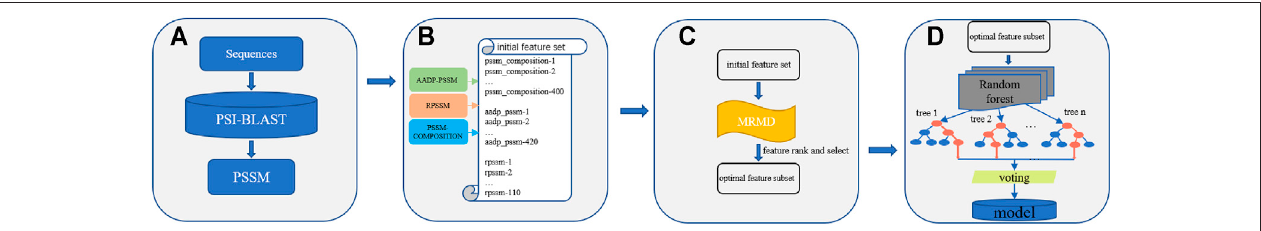
FIGURE1| FrameworkofKK-DBP. StepA :ConstructionofPositionSpeci fi cityScoreMatricesforproteinsequences. StepB: Extractionofthreefeatures:AADP- PSSM, PSSM-COMPOSITION, and RPSSM as the initial feature set for a single sample. Step C: Feature ranking and selection using the MRMD algorithm. Step D: Identi fi cation of DBP using random forests.